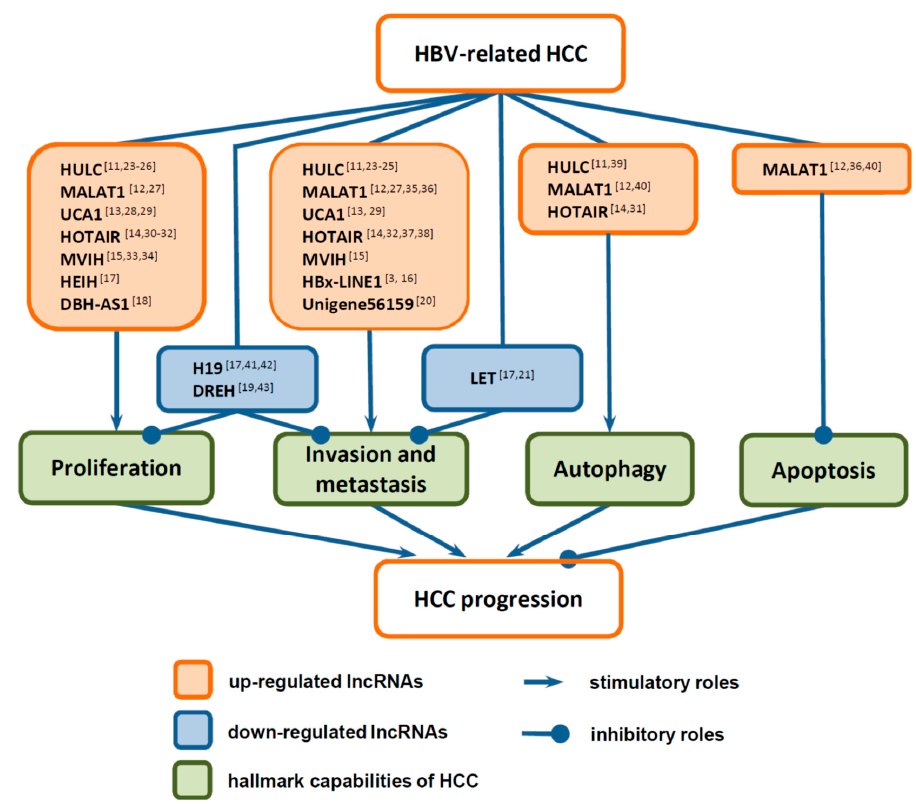
Figure 1. Dysregulated long non-coding RNAs (lncRNAs) in hepatitis B virus (HBV)-related hepatocellular carcinoma (HCC) and their functions in HCC progression, including the modulation of HCC cell proliferation, invasion and metastasis, autophagy, and apoptosis [23–43].